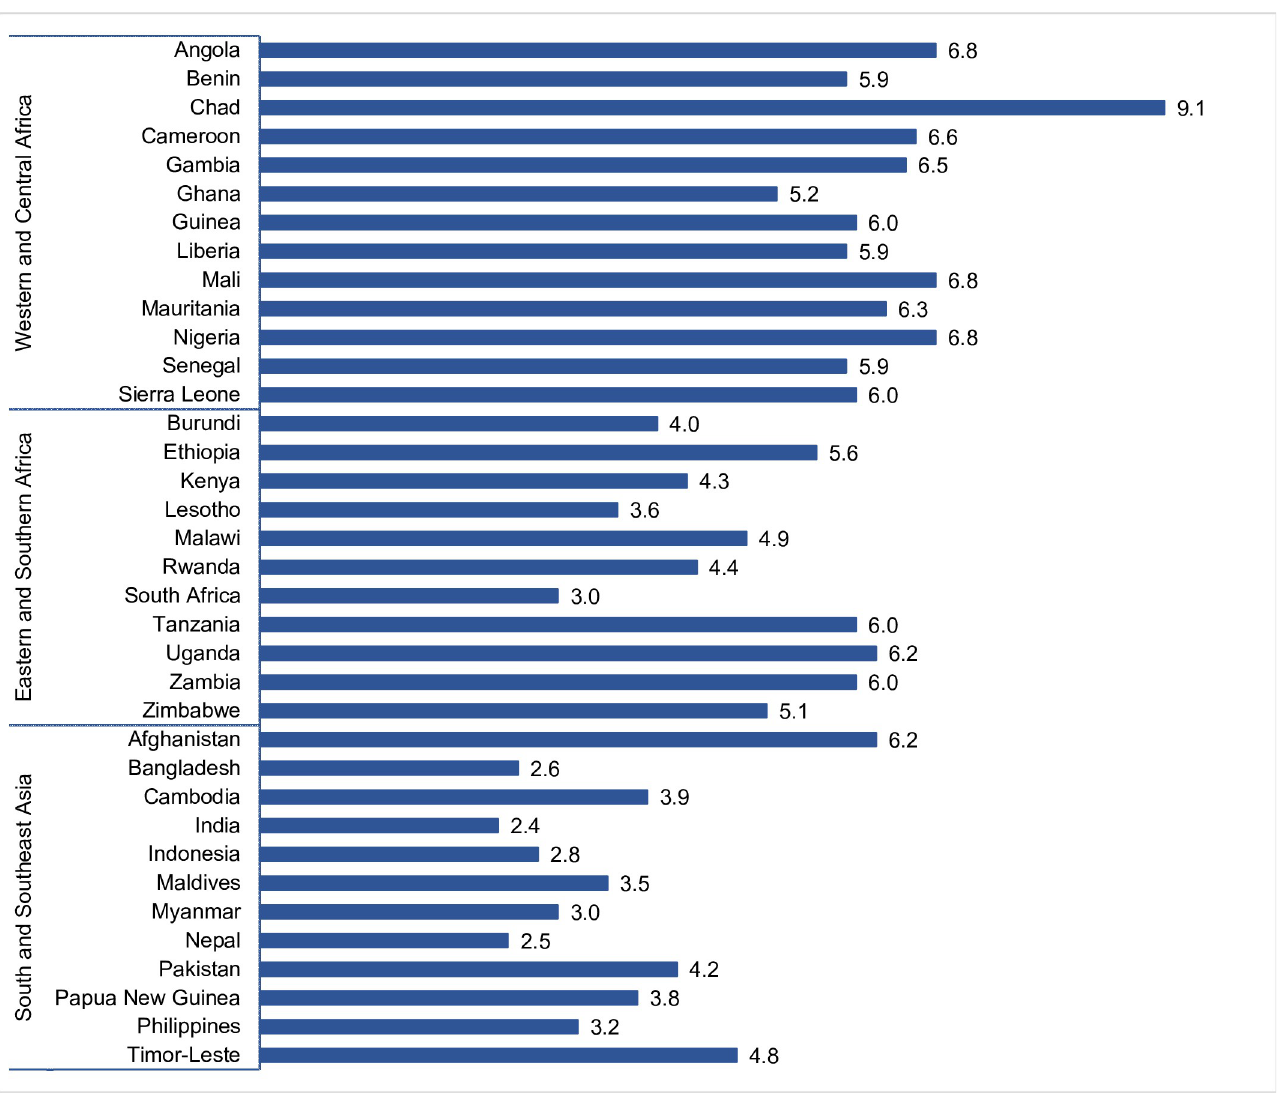
PLOS ONE | https://doi.org/10.1371/journal.pone.0276595 November4,